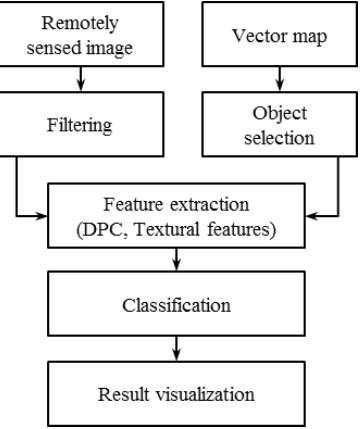
Figure 2. Steps involved in object-based change detection.